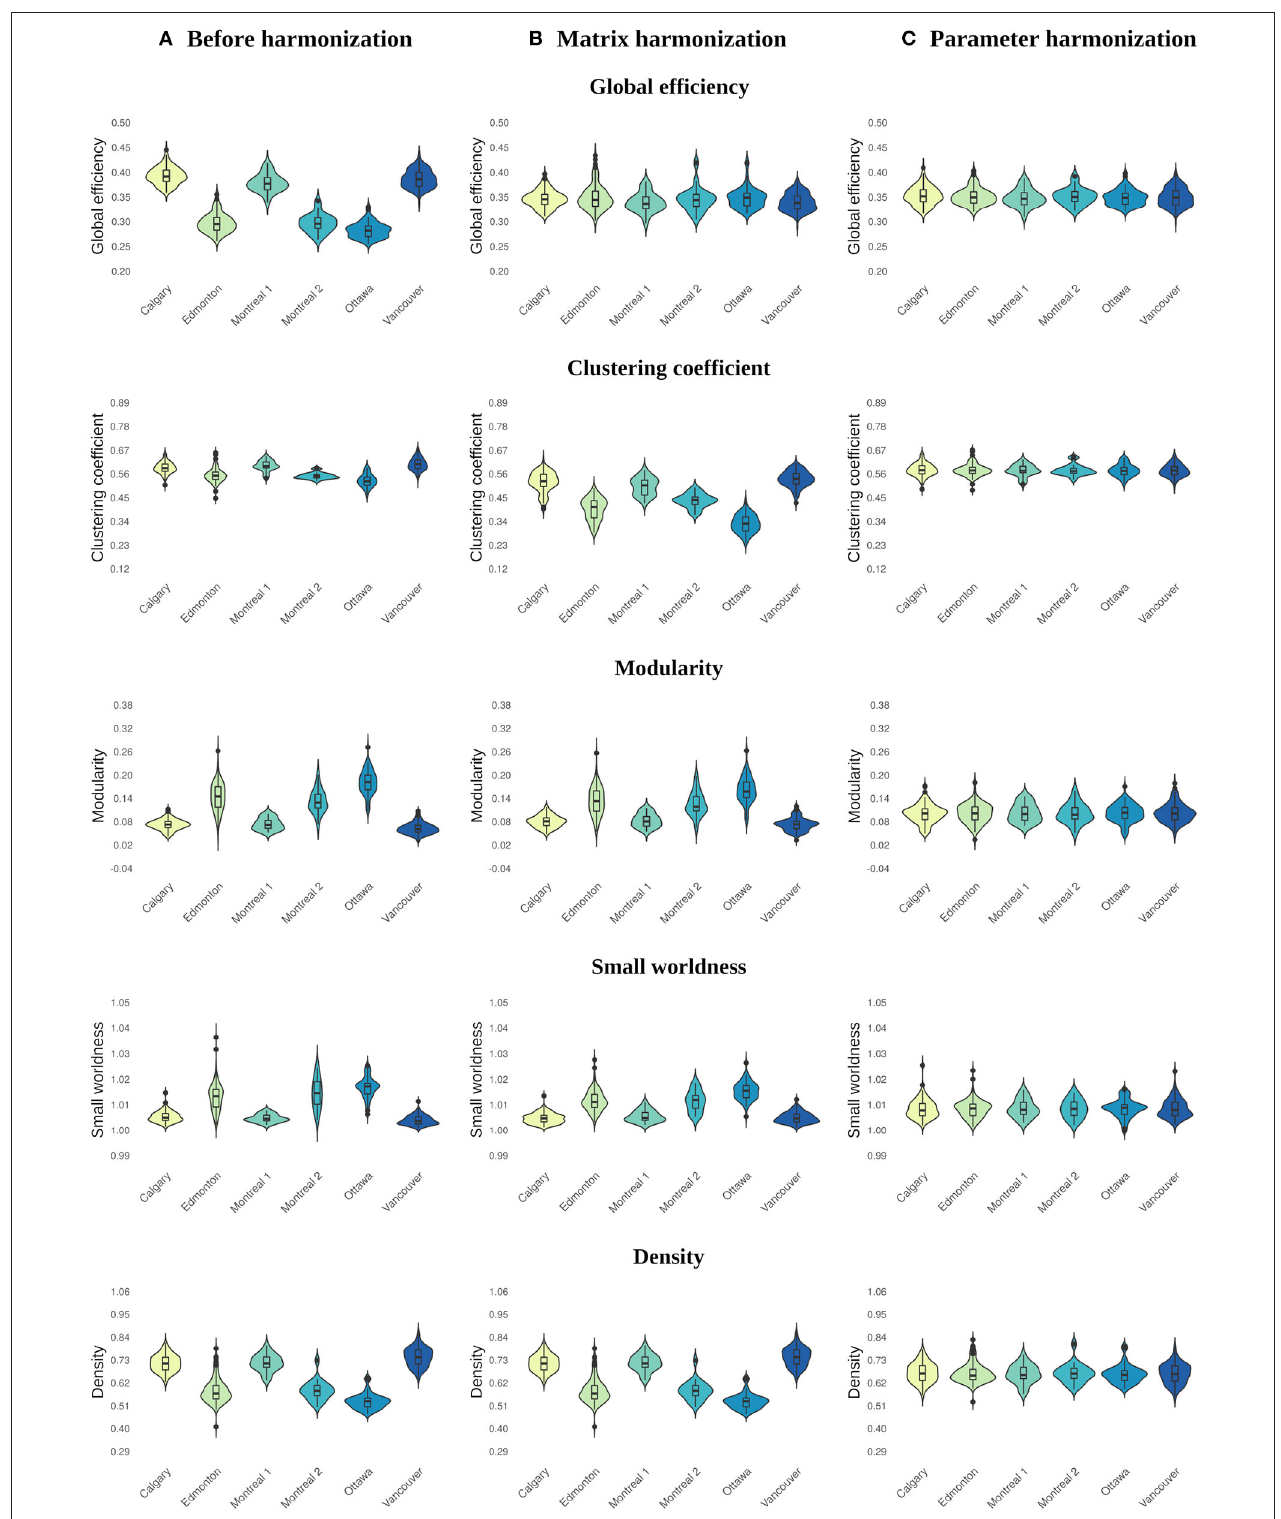
FIGURE 2 | Violin plots illustrating the distribution of values across sites for global network parameters calculated (A) before harmonization, after (B) matrix, and (C) parameter harmonization.